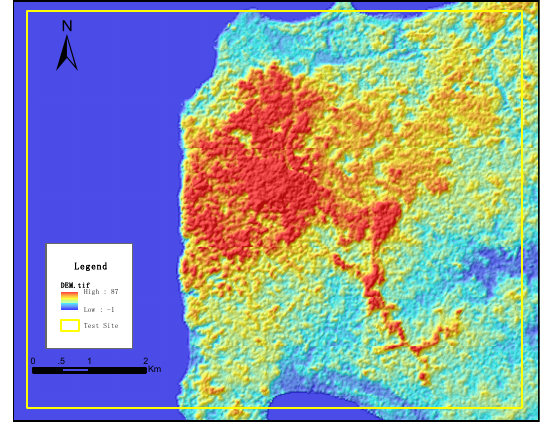
Figure 2. DEM and test site